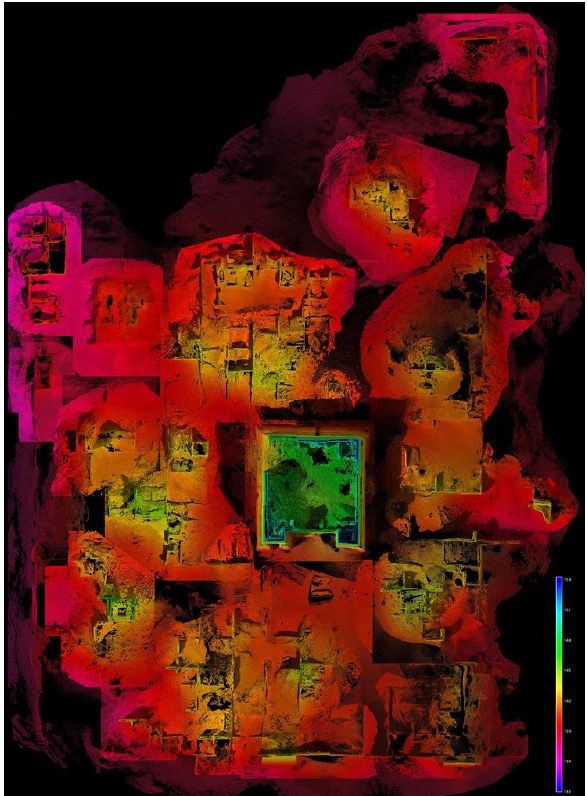
Figure 7. Orthophoto of the complex. The images is visualized as a depth map to better understand the different elevation of the